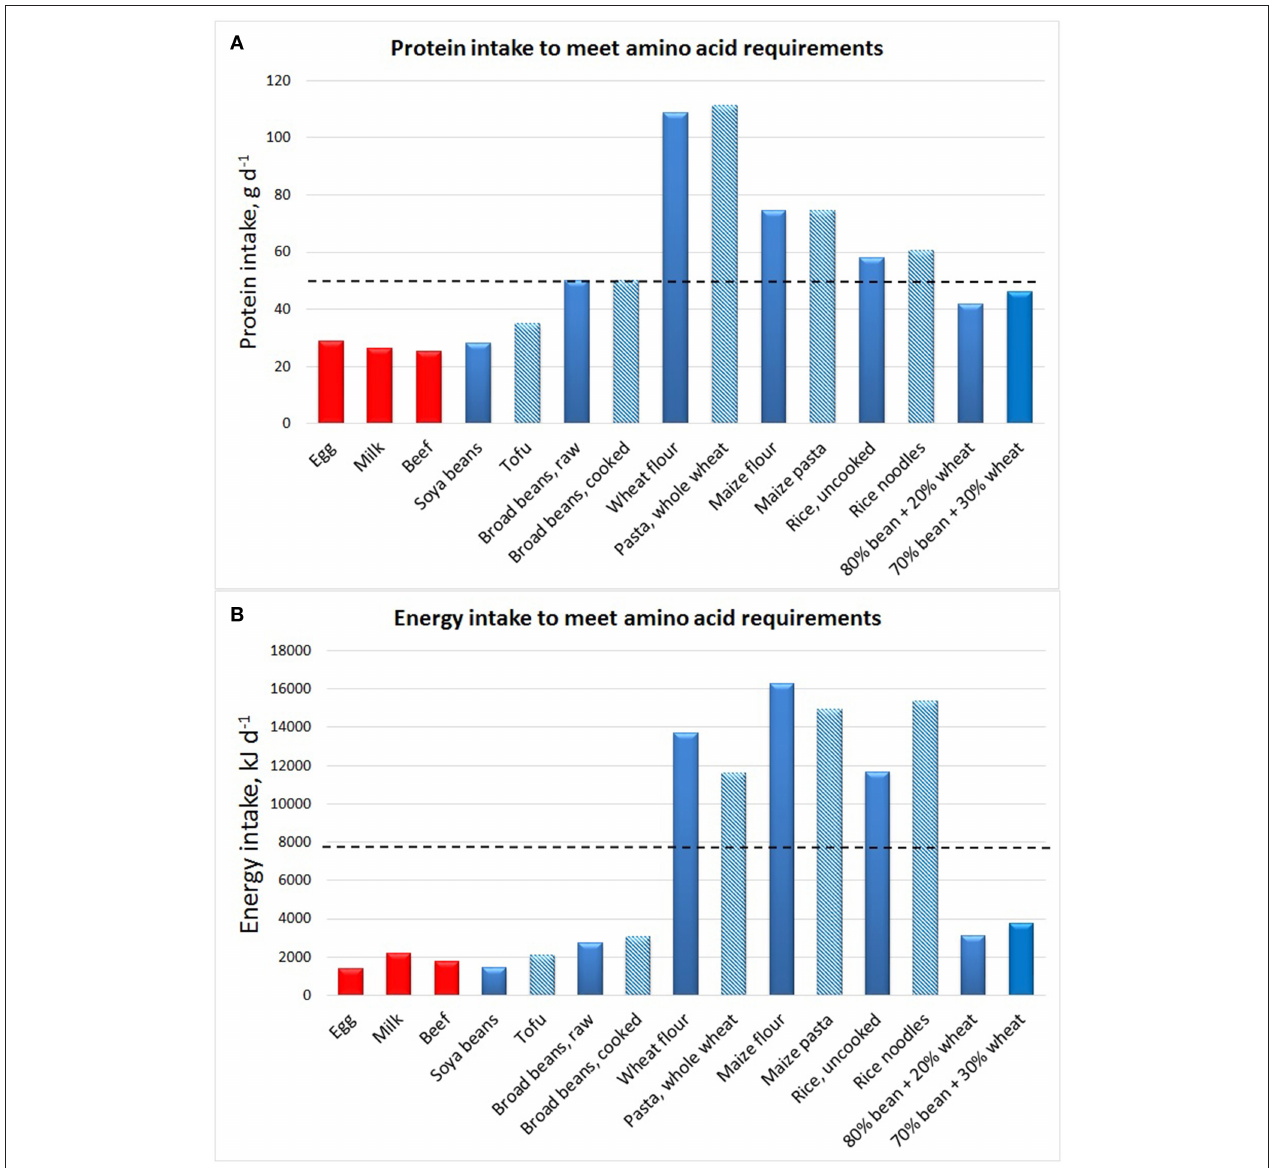
FIGURE 3 | Protein (A) and energy (B) obtained from selected food items corresponding to an amount that would fulfill the daily lysine and sulfur amino acid requirements of a 70kg adult. The red bars indicate animal products, blue bars plant-based products and shaded bars cooked products. The horizontal broken lines indicate the recommend daily intake of total protein and energy. The figure shows that having cereals as the primary lysine source would lead to overconsumption of energy and protein. The combinations of beans and wheat indicate the protein and energy intakes when either 70 or 80% of the daily lysine requirement is obtained from broad beans and the rest from whole grain